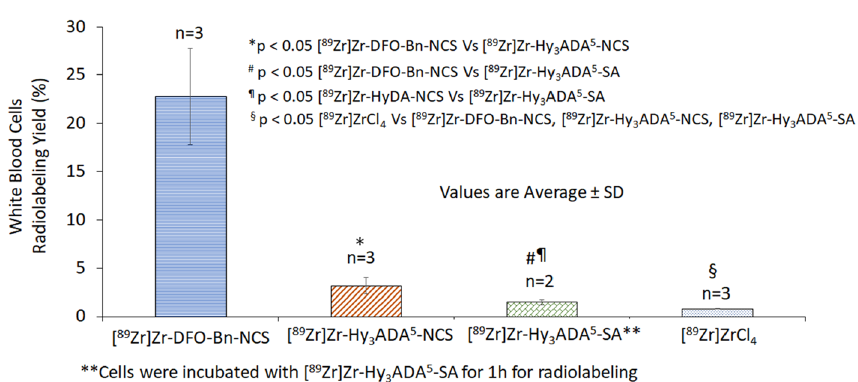
Figure 3. Radiolabeling of white blood cells (WBCs) with [ 89 Zr]Zr-DFO-Bn-NCS, [ 89 Zr]Zr-Hy 3 ADA 5 -NCS,